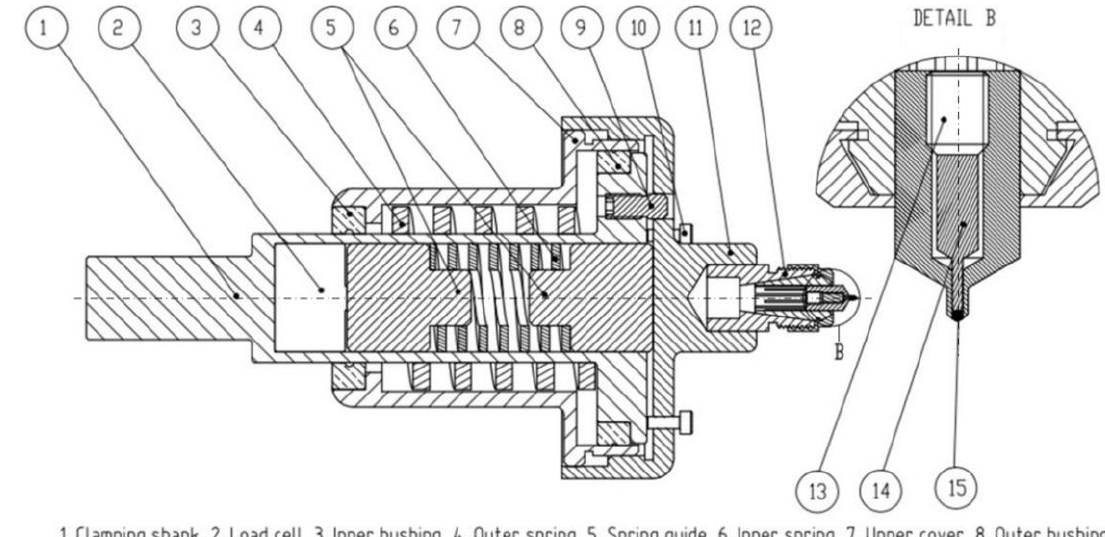
Figure 9. Design of the load cell-embedded small ball-burnishing tool.